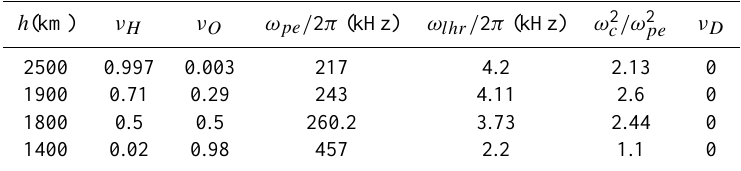
Table 1. ν H and ν O are the relative content of Hydrogen and Oxygen, respectively; ω pe / 2 π and ω lhr / 2 π are the electron plasma and the LHR frequencies in kHz; ω 2 c /ω 2 pe is the square of the electron gyrofrequency to the electron plasma frequency of the background plasma; ν D = 0 corresponds to the absence of negative ions. These values are presented for the set of altitudes indicated in the first column (in km) and for a fixed latitude of 5 degrees.